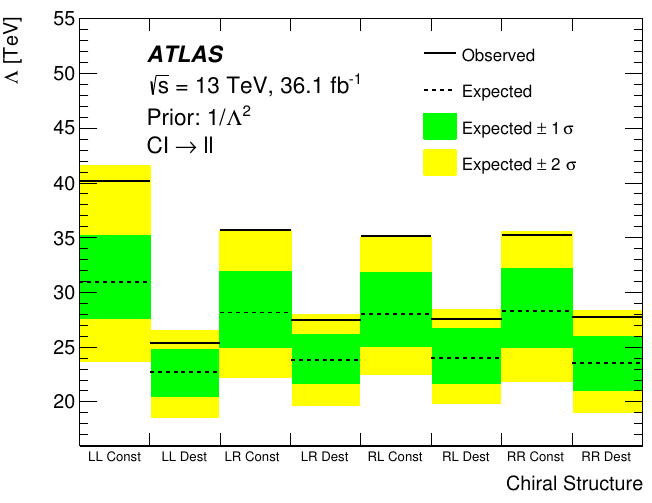
Figure 7 . Lower limits on the energy scale (cid:3) at 95% CL, for the Contact Interaction model with constructive (const) and destructive (dest) interference, and all considered chiral structures with left-handed (L) and right-handed (R) couplings. Results are shown for the combined dilepton